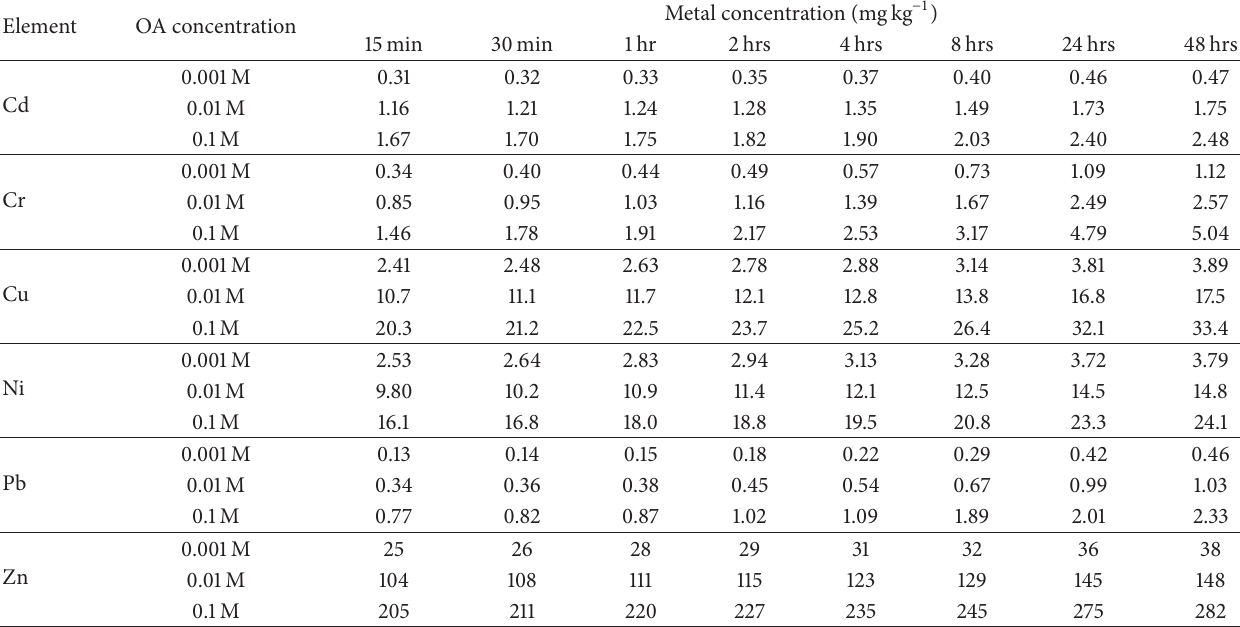
Table 6: Metals release kinetics of biosolid-treated Romona soil (1,080 Mgha −1 ) in different concentrations of organic acid (OA) mixtures. Element